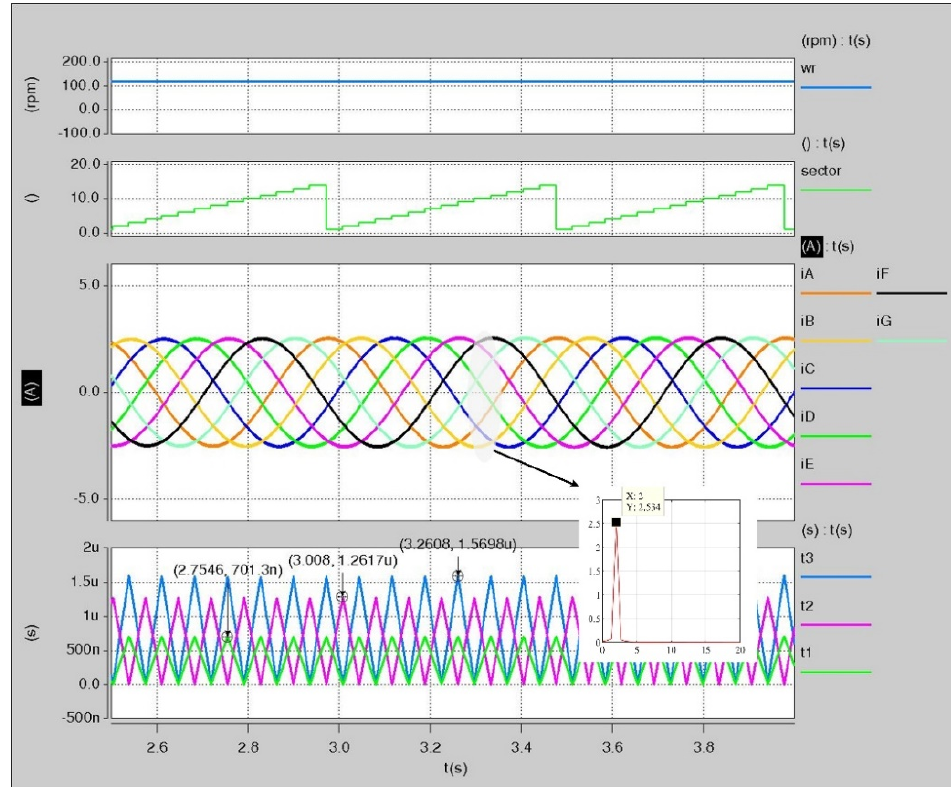
Figure 6. Sensored operation of the five phase motor.